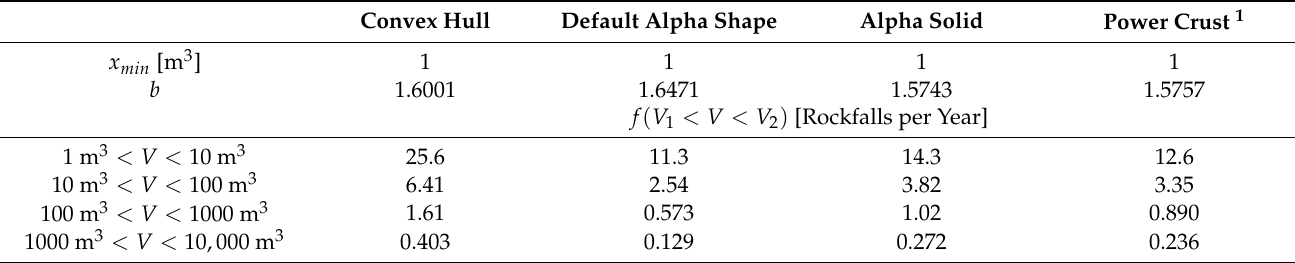
Table 3. Upper : Power-law PDF fits for each of the datasets utilizing MLE with a defined x min of 1 m 3 ; Lower : annual rockfall frequency